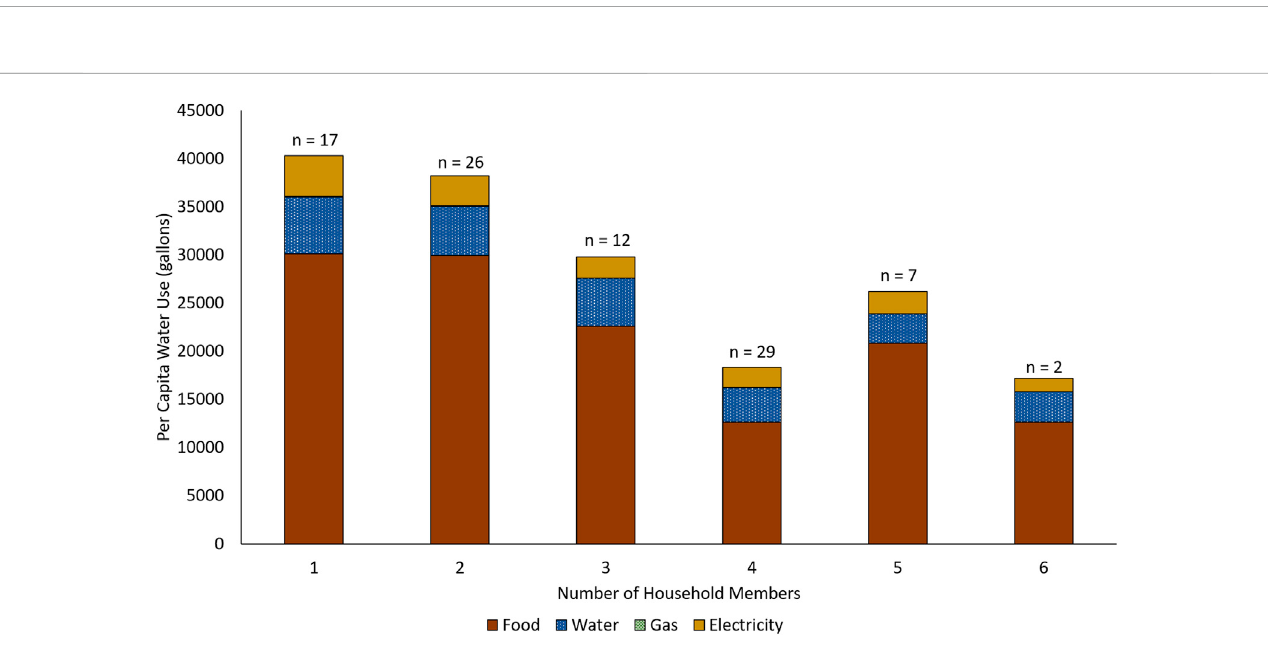
FIGURE 7 Average monthly total (direct + indirect) water use by FEW consumption category and household size in